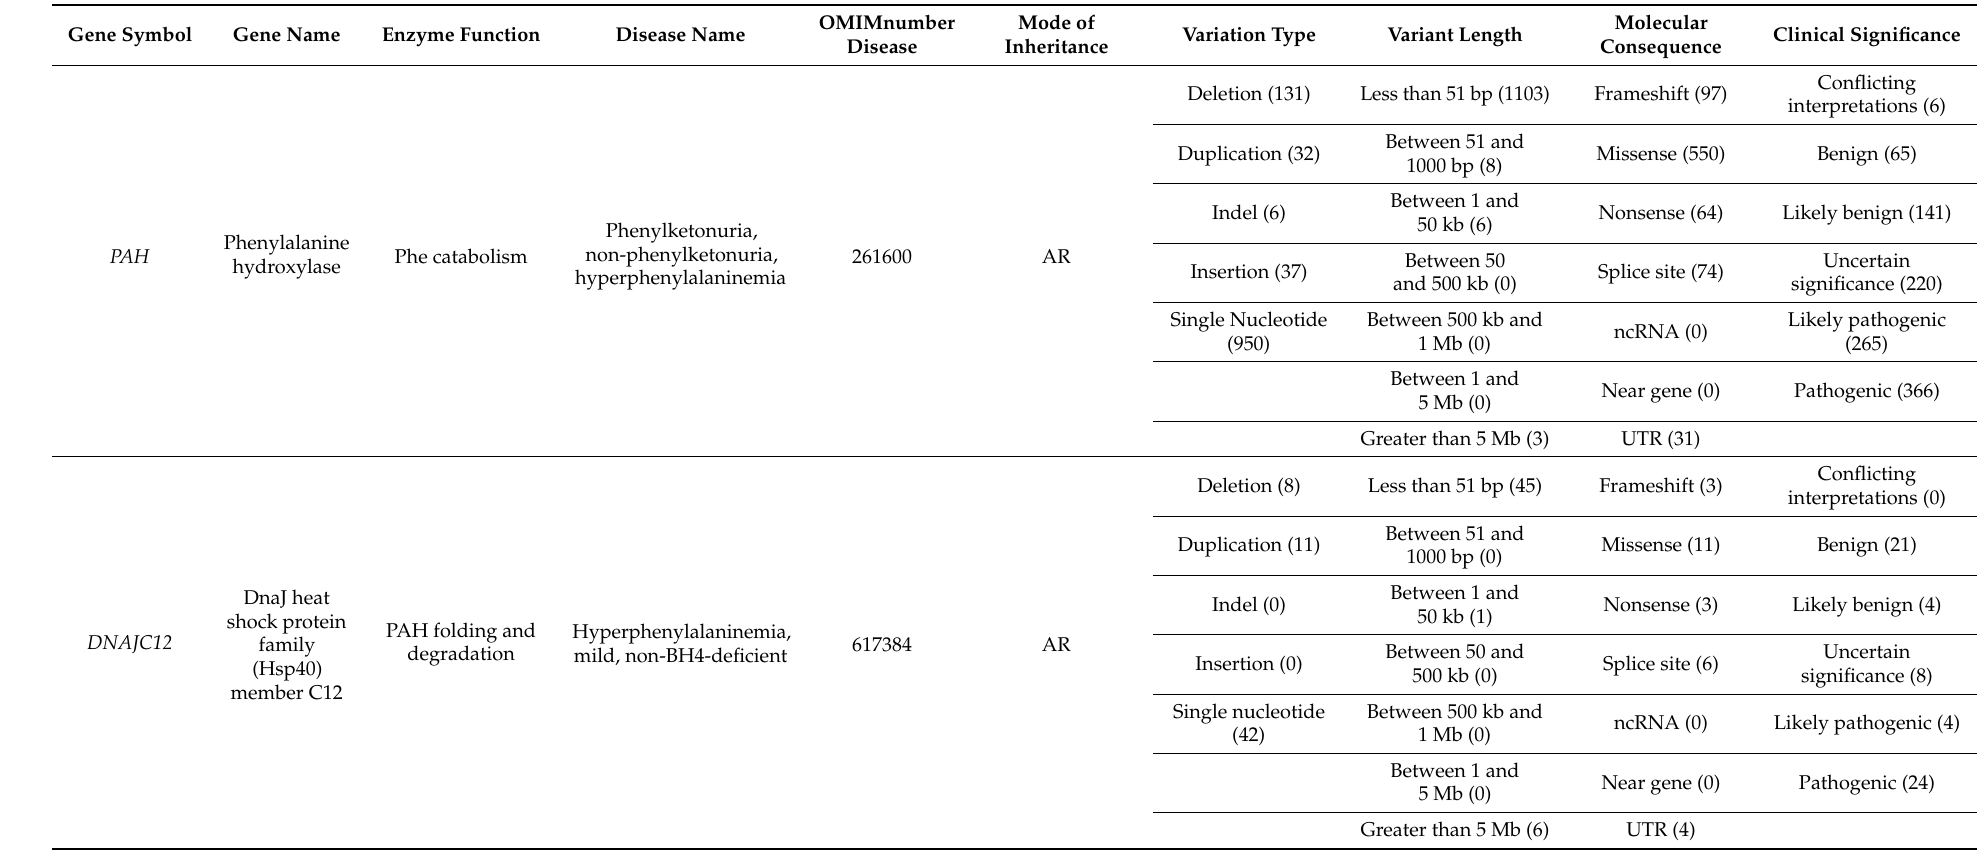
Table 1. Genetic causes of